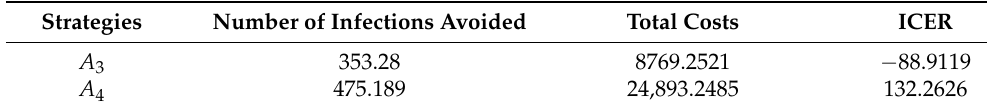
Table 4. Second revised comparison of strategic cost table. Strategies Number of Infections